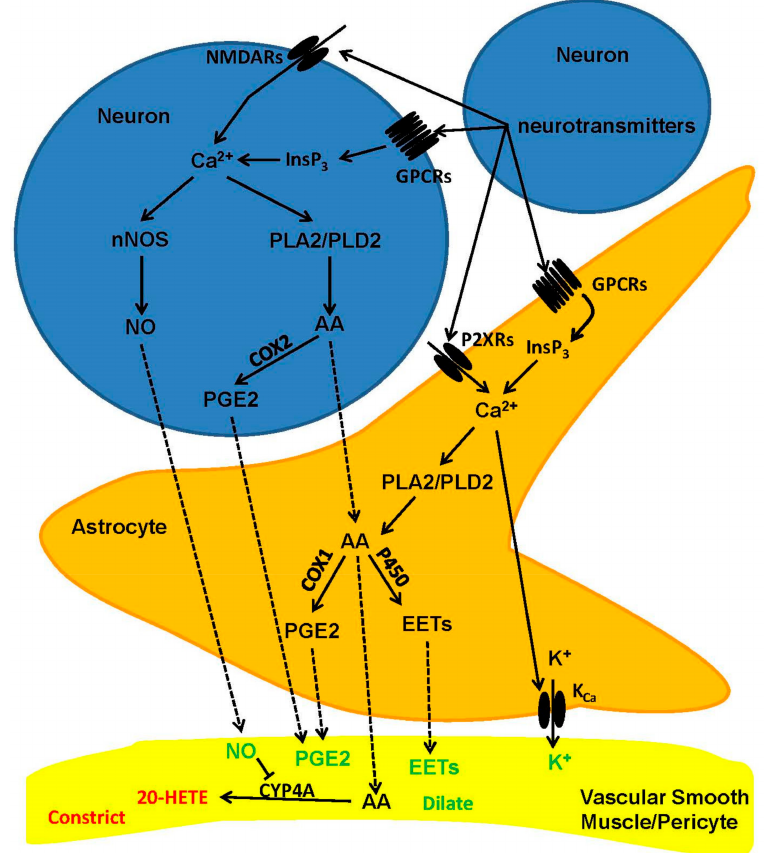
Figure 2. The mechanisms by which neurons and astrocytes stimulate arteriole and capillary dilation in response to synaptic